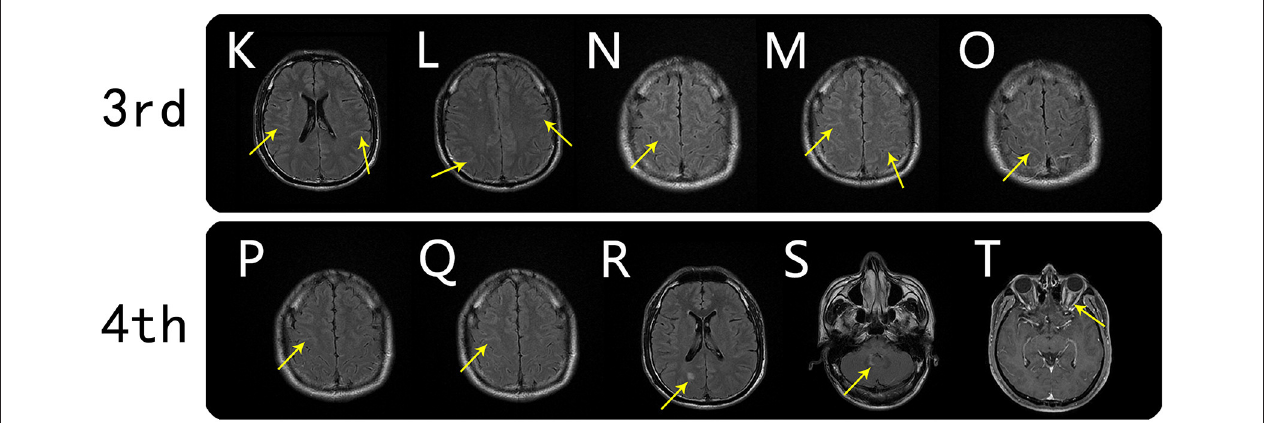
FIGURE 2 | Brain MRI findings from the third and fourth scans. Third MRI scan (on day 22): axial FLAIR showed reduced meningo-cortical lesions that were still clearly observable ( K–O , arrows). Fourth MRI scan (on day 37): axial FLAIR showed that the meningo-cortical lesions were further resolved ( P and Q , arrows), but new lesions were present in the right parietal cortex and right cerebellar dentate nucleus ( R and S , arrows). T1-weighted postgadolinium-enhanced image showing left optic nerve thickening and obvious enhancement ( T , arrow).